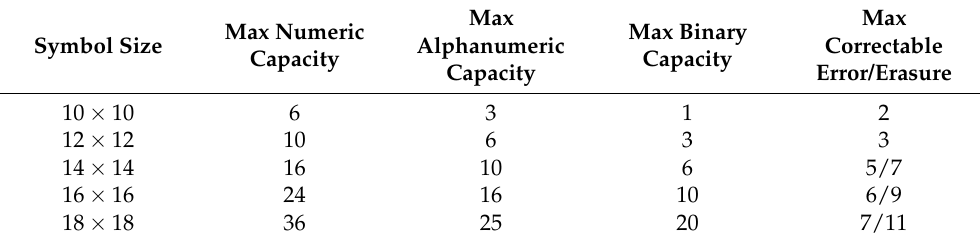
Table 2. The size, capacity, and error correction features of each Data Matrix format. Max Symbol Size